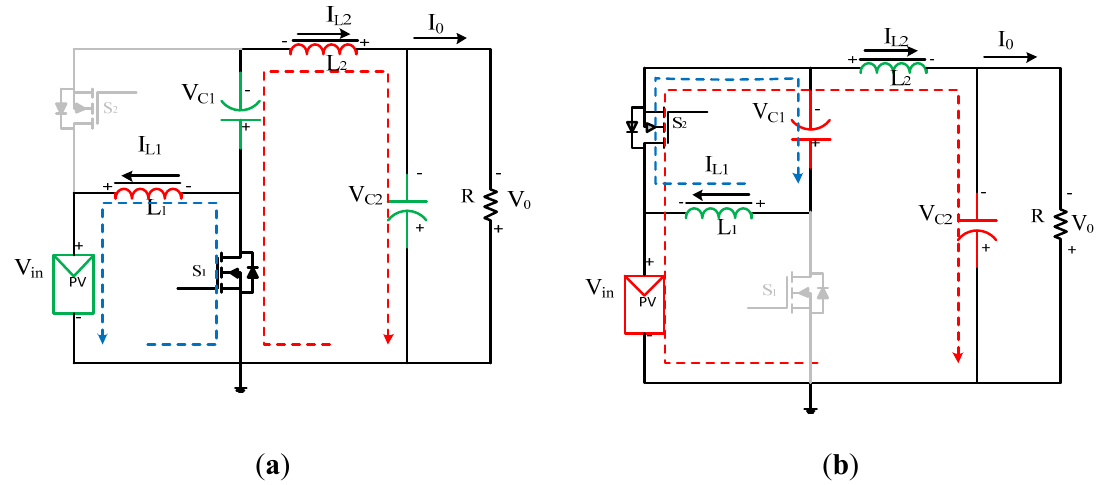
Figure 6. Modes of operation of semi-Z-source inverters when D > 0.5: ( a ) State I; ( b ) State